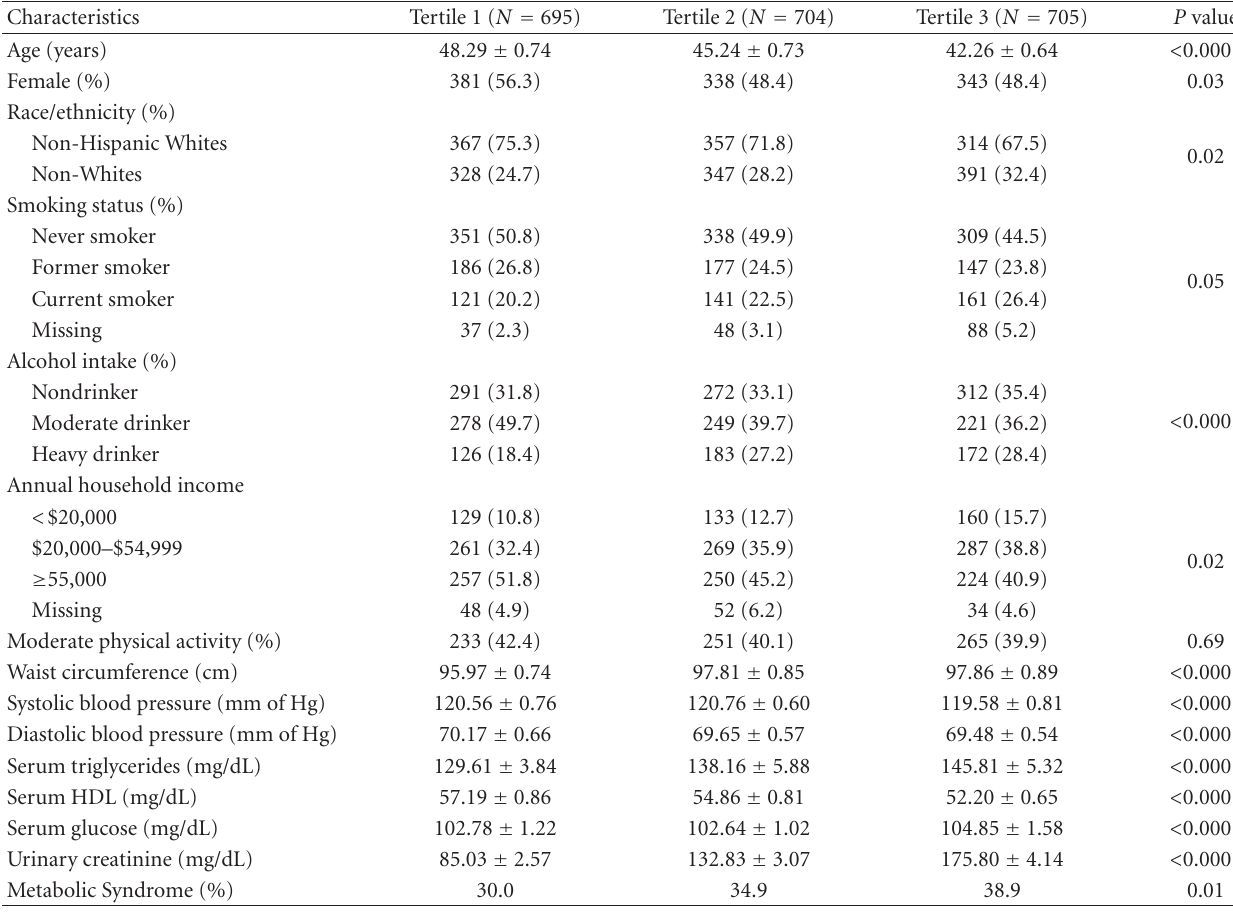
Table 1: Characteristics of the study population from NHANES 2003–2008 a .